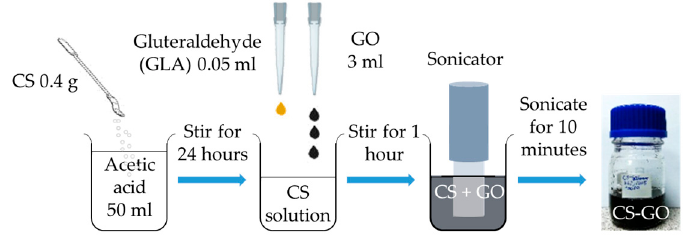
Figure 1. The in-house synthesis of the CS–GO nanocomposite.